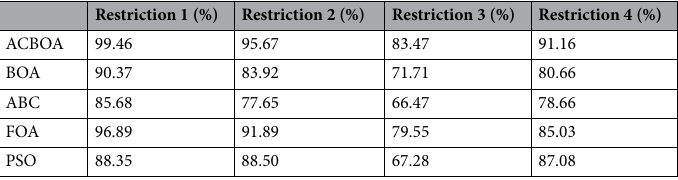
Table 3. Coverage efficiency with different monitoring area size, number of nodes, sensing radius and communication